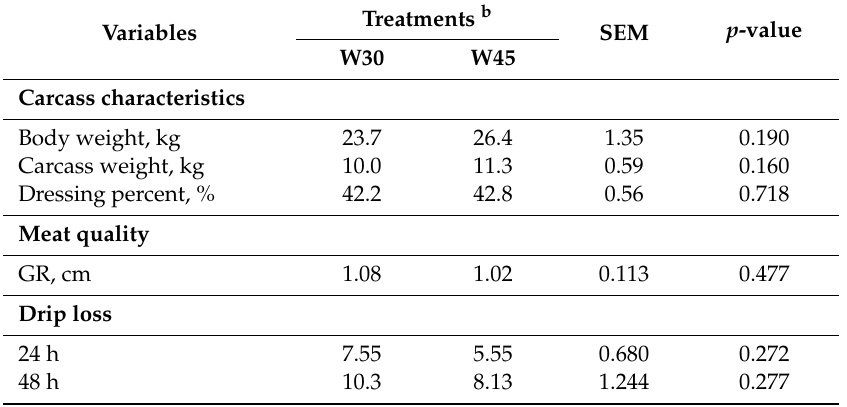
Table 3. Carcass characteristics and meat quality of lambs slaughtered at age of 120 d a